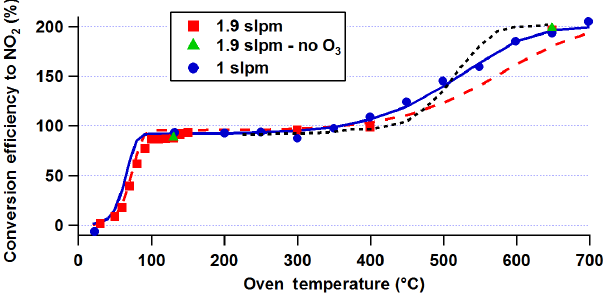
Figure 6. Thermogram of N 2 O 5 measured in the NOAA TD-CRDS at two flow rates. The red squares and red dashed line show the 1.9slpm thermogram and simulation, while the blue circles and blue solid line show the analogous result at 1.0slpm. The first dis- sociation corresponds to N 2 O 5 → NO 2 + NO 3 and the second to NO 3 → NO 2 + O. The second curve reaches a maximum of 200%, while the first reaches 90–95%, depending on the flow rate, due to recombination of NO 2 and NO 3 in the cooling region prior to the detector region. The black dashed line is the experimental HNO 3 thermogram from Fig. 2, offset by 100%. The green triangles in- dicate measurements of the conversion efficiency without the O 3 addition, confirming that the second dissociation must occur via NO 3 → NO 2 + O rather than NO 3 → NO + O 2